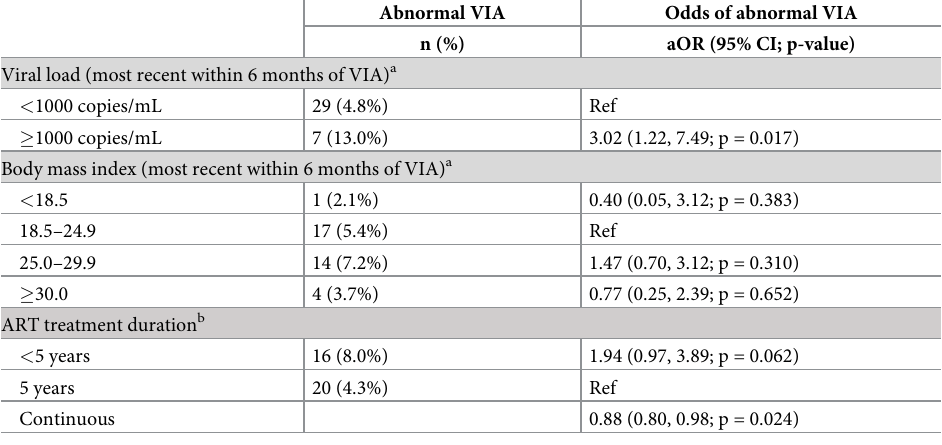
Table 3. Association between abnormal VIA (pre-cancerous or cancerous lesion) and HIV clinical characteristics among women living with HIV screened for the first time (n = 665). Abnormal VIA Odds of abnormal VIA n (%) aOR (95% CI; p-value) Viral load (most recent within 6 months of VIA) a < 1000 copies/mL 29 (4.8%) Ref � 1000 copies/mL 7 (13.0%) 3.02 (1.22, 7.49; p = 0.017) Body mass index (most recent within 6 months of VIA) a < 18.5 1 (2.1%) 0.40 (0.05, 3.12; p = 0.383) 18.5–24.9 17 (5.4%) Ref 25.0–29.9 14 (7.2%) 1.47 (0.70, 3.12; p = 0.310) � 30.0 4 (3.7%) 0.77 (0.25, 2.39; p = 0.652) ART treatment duration b < 5 years 16 (8.0%) 1.94 (0.97, 3.89; p = 0.062) 5 years 20 (4.3%) Ref Continuous 0.88 (0.80, 0.98; p = 0.024) aOR, adjusted odds ratio; VIA, visual inspection with acetic acid; ART, antiretroviral therapy. a Adjusted odds ratio controlling for age (categorical), year of screening, and duration on ART. b Adjusted odds ratio controlling for age (categorical) and year of